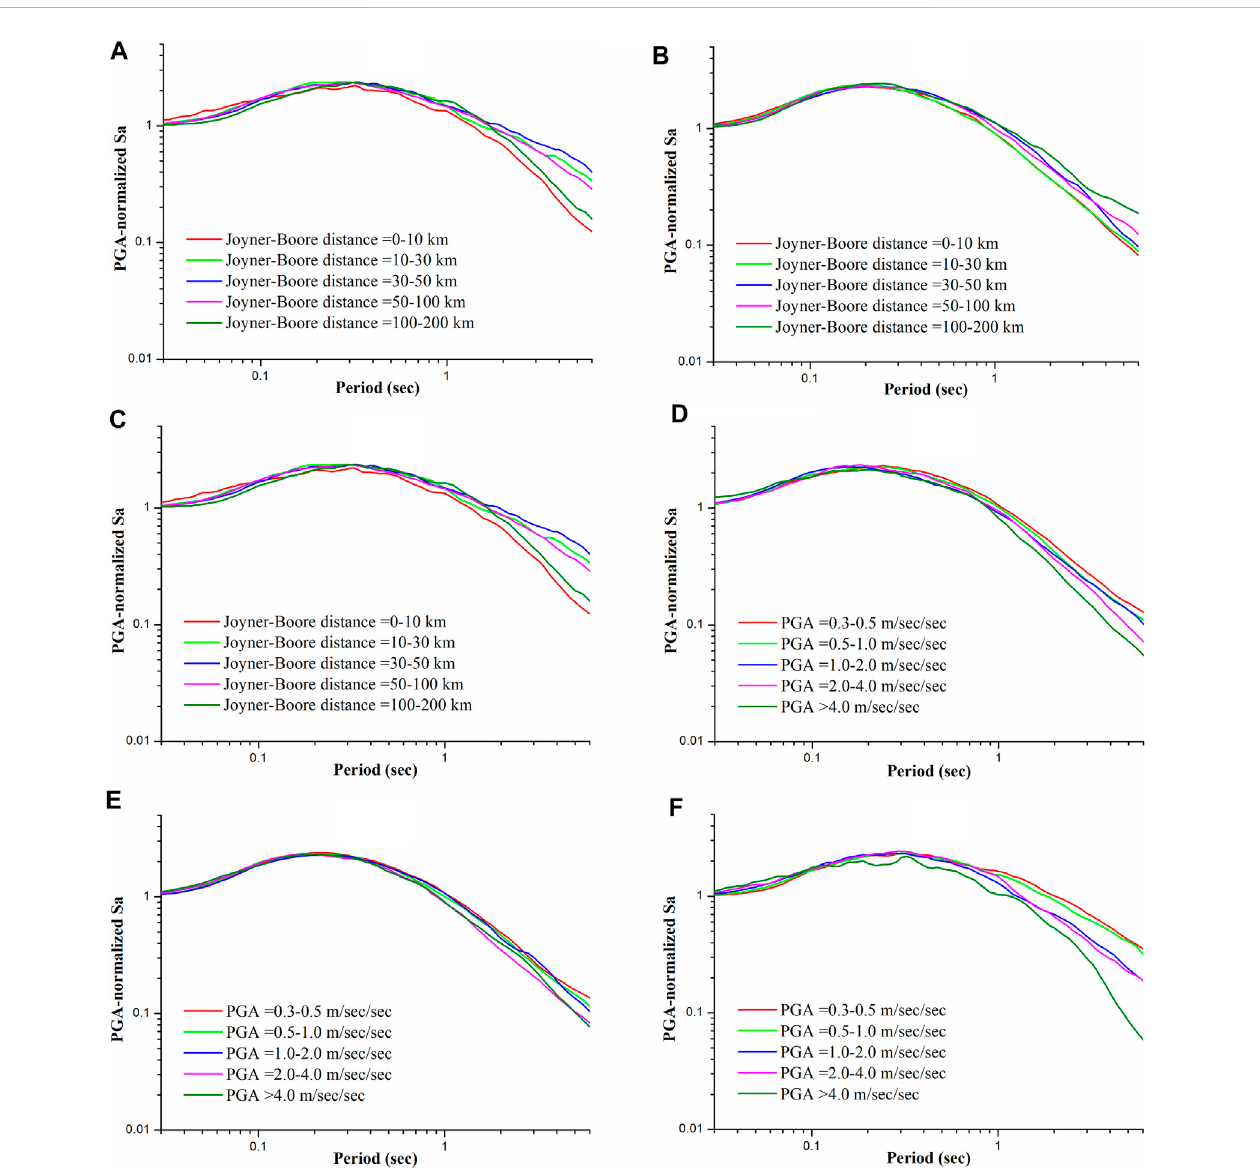
FIGURE 4 Mean values for PGA-normalized Sa with different Joyner-Boore distance intervals on (A) site class I, (B) site class II, (C) site class III, and mean values for PGA-normalized Sa with different PGA intervals on (D) site class I, (E) site class II, and (F) site class III.